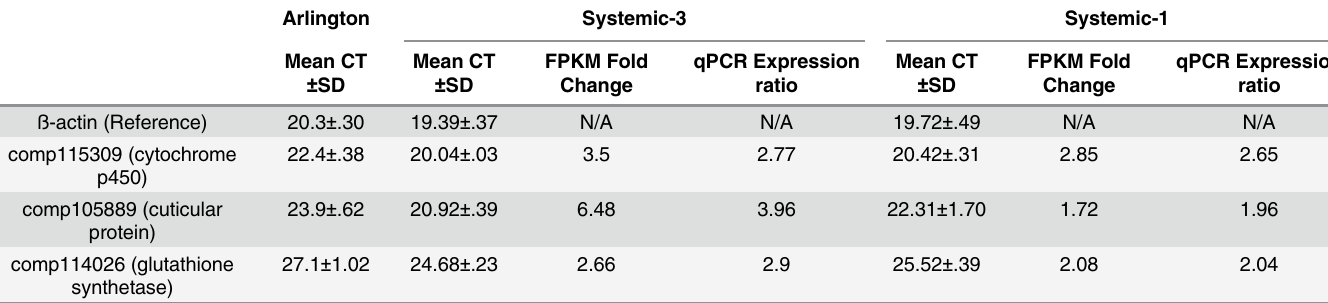
Table 6. Gene expression determined by quantitative